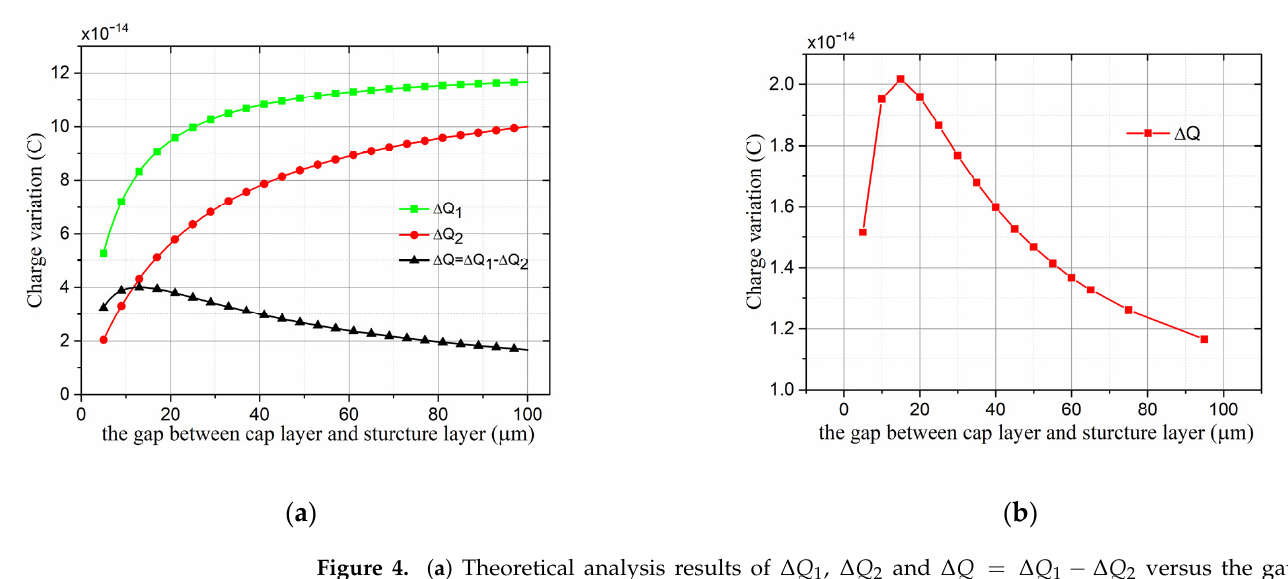
Figure 4. ( a ) Theoretical analysis results of ∆ Q 1 , ∆ Q 2 and ∆ Q = ∆ Q 1 − ∆ Q 2 versus the gap ( d 1 ) between the cap and working electrodes. ∆ Q 1 and ∆ Q 2 are defined in Equations (8) and (9). ( b ) Simulation result of ∆ Q = ∆ Q 1 − ∆ Q 2 versus the gap ( d 1 ) between the cap and working electrodes.